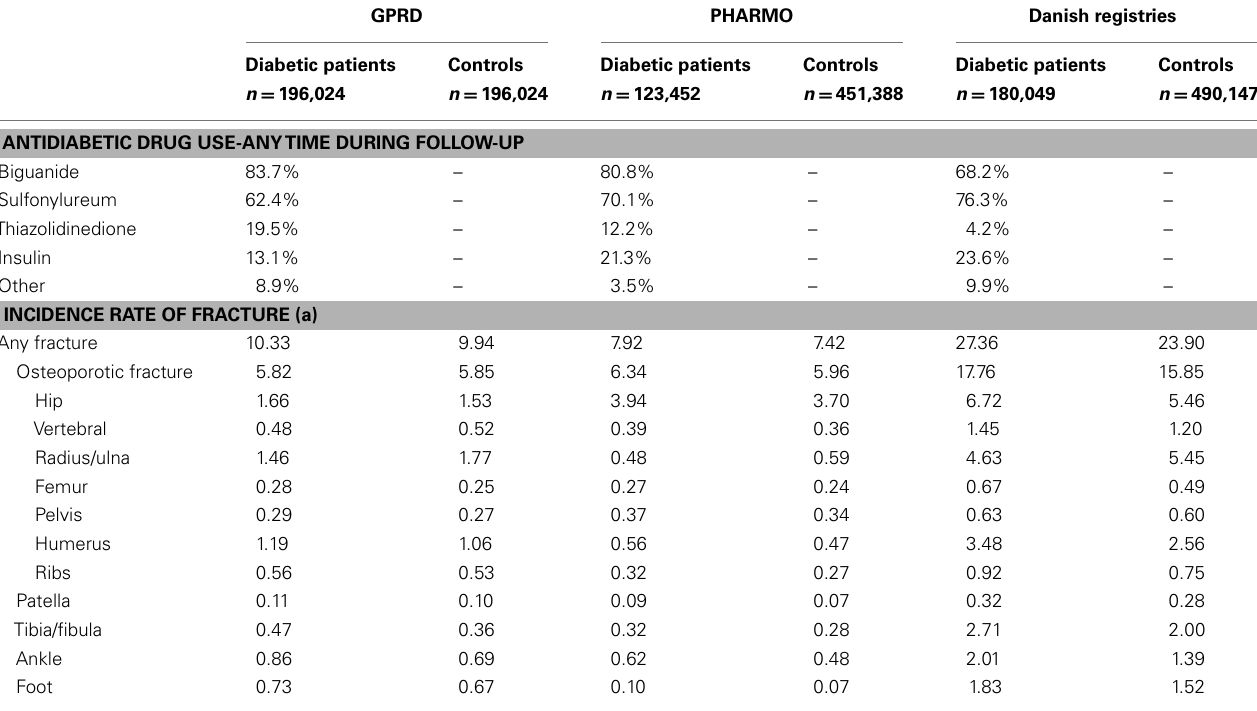
Table 2 | Use of antidiabetic medication and incidence rate of fractures during follow-up. GPRD PHARMO Danish registries Diabetic patients Controls Diabetic patients Controls